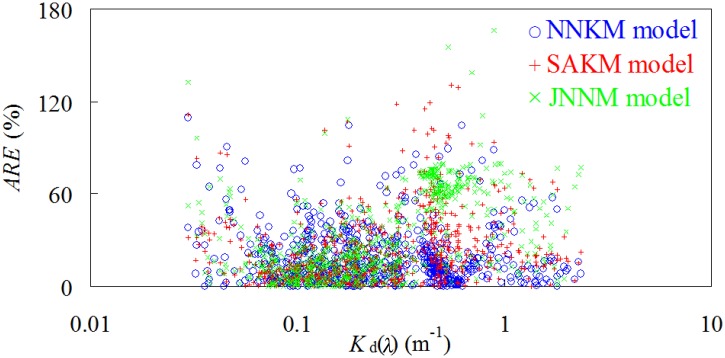
ARE values of K
d(λ) predictions plotted versus measured K
d(λ) in the Yellow Sea and China East Sea (174 samples).